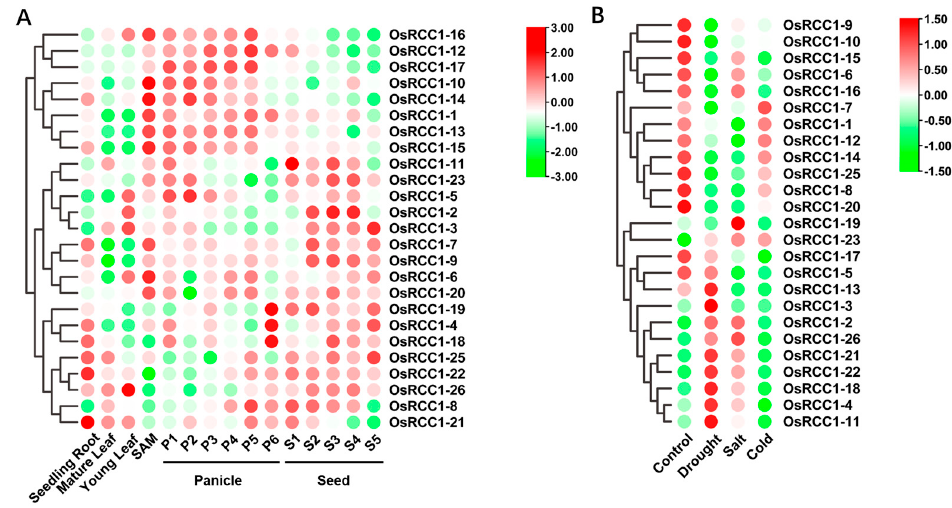
Figure 7. Expression patterns of OsRCC1s from microarray data. ( A ) Expression patterns of OsRCC1s in diverse tissues and across various developmental stages. The sample sources are as follows: roots of 7-day-old seedling, mature leaf (collected before pollination), young leaf, shoot apical meristem (SAM), P1 (0–3 cm panicle), P2 (3–5 cm panicle), P3 (5–10 cm panicle), P4 (10–15 cm panicle), P5 (15–22 cm panicle), P6 (22–30 cm panicle), S1 (0–2 DAP), S2 (3–4 DAP), S3 (5–10 DAP), S4 (11–20 DAP) and S5 (21–29 DAP). Different stages of panicle and seed development have been categorized according to panicle length and days after pollination, respectively. ( B ) Expression patterns of OsRCC1s under three different abiotic stress conditions. Seven-day-old rice seedlings were subjected to salinity (200 mM NaCl), dehydration (dried between folds of tissue paper) and cold (4 ◦ C) treatments for 3 h. The seedlings kept in water for 3 h at 28 ± 1 ◦ C served as control. The color scale represents log 2 of average signal values. The red color shows the higher and the green color shows the lower expression levels in expression